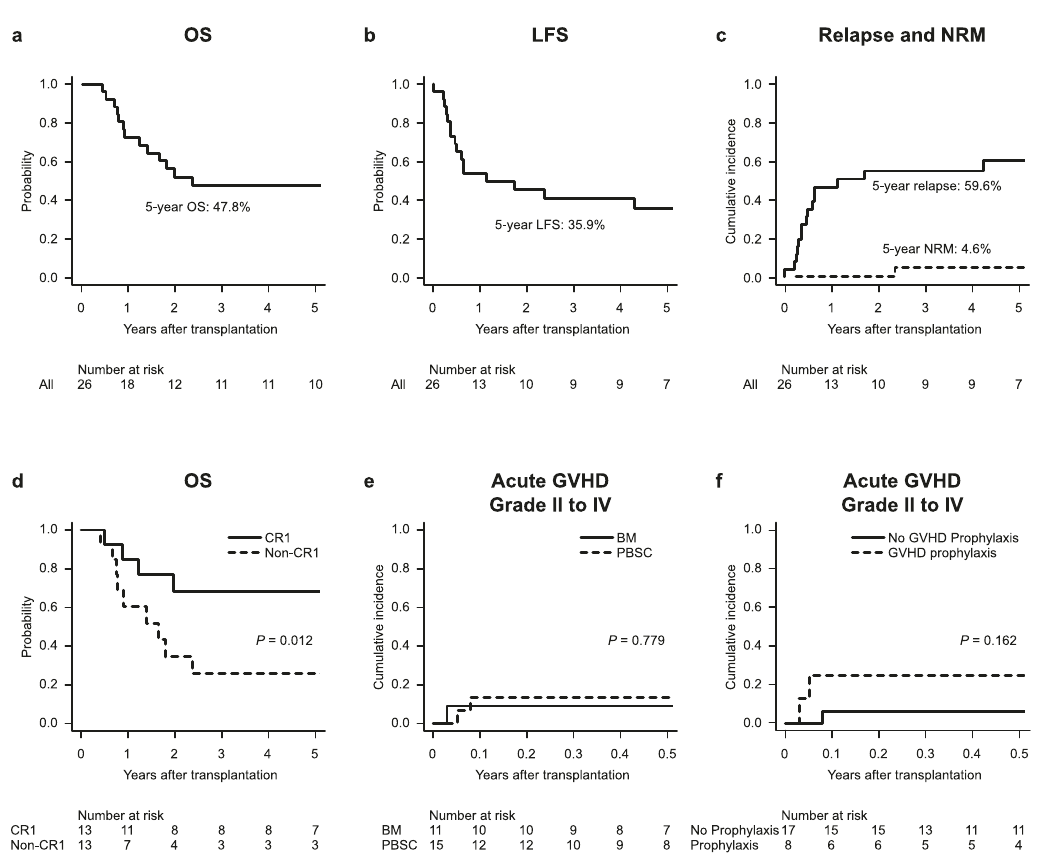
Fig. 2 Transplant outcomes in the syngeneic group. a Overall survival (OS) rate, b leukemia-free survival (LFS) rate, and c cumulative incidence of relapse and non-relapse mortality (NRM) in the syngeneic (Syn) group. d OS strati fi ed by disease status at hematopoietic stem cell transplantation. e Cumulative incidence of grade II – IV acute graft-versus-host disease (GVHD), strati fi ed by graft source. f Cumulative incidence of grade II – IV acute GVHD, strati fi ed by GVHD prophylaxis status. BM bone marrow, CR1 fi rst complete remission, PBSC peripheral blood stem